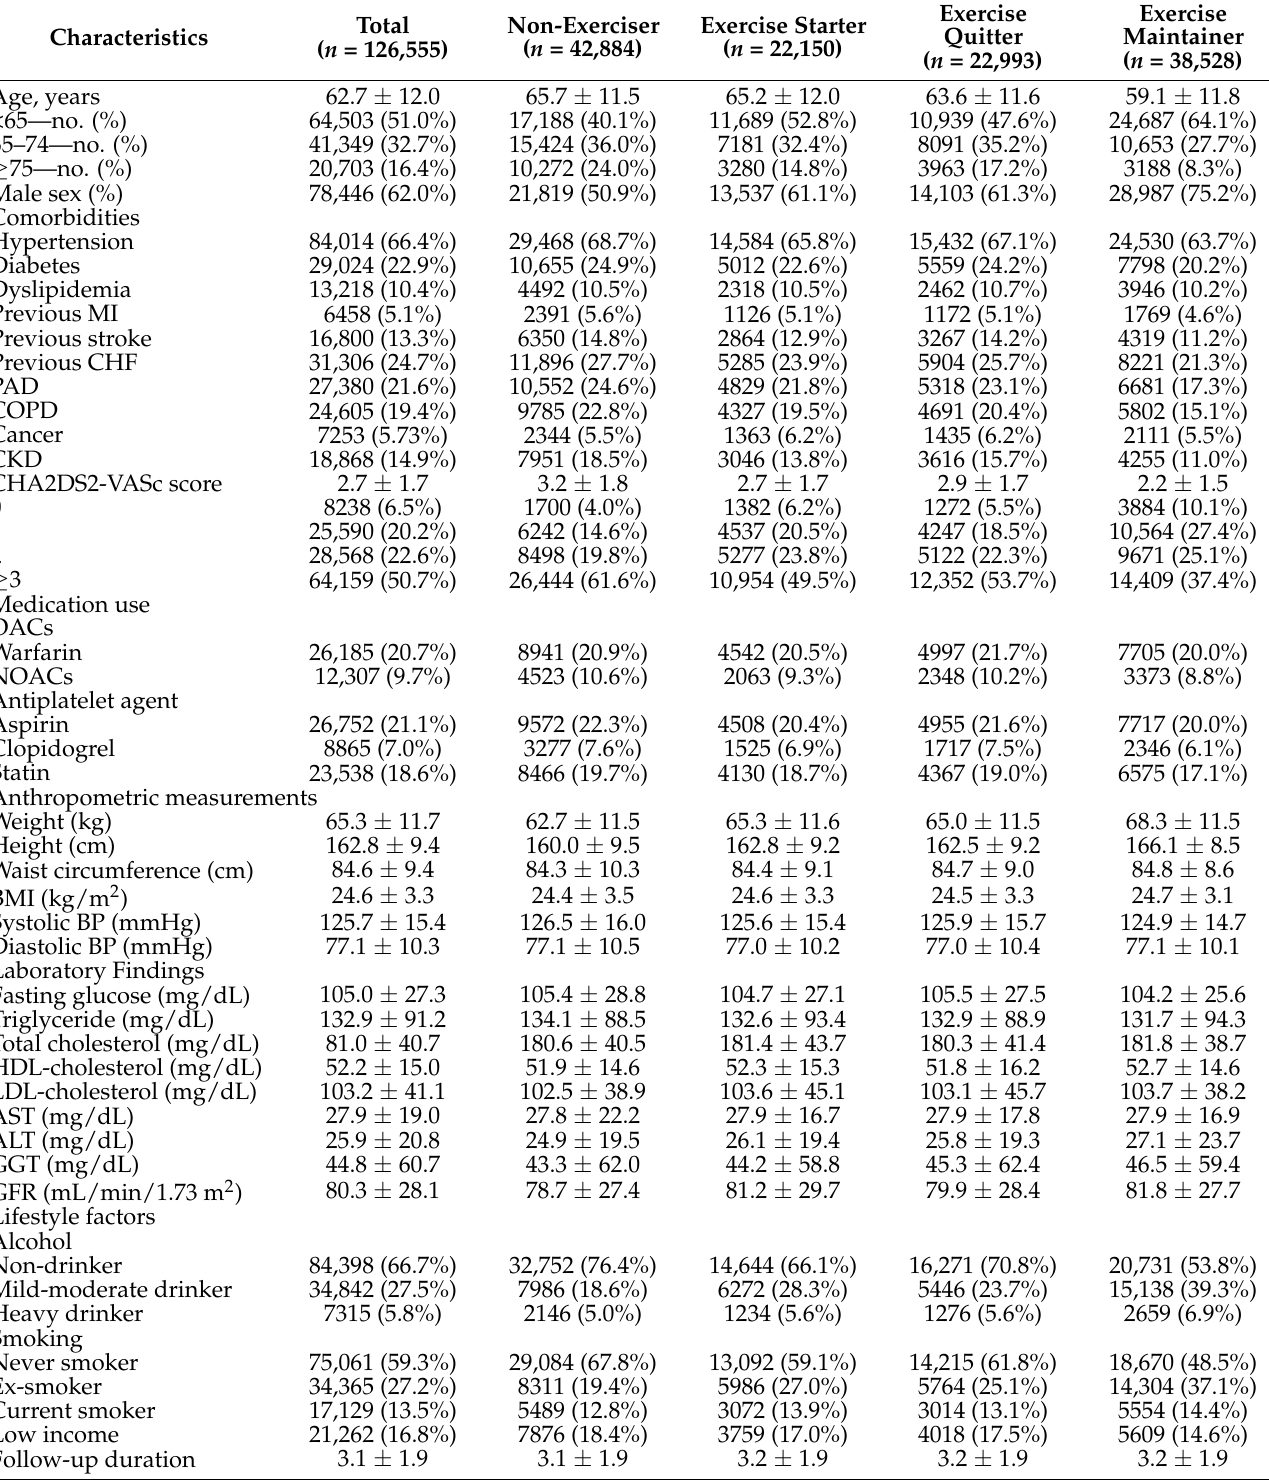
Table 1. Baseline